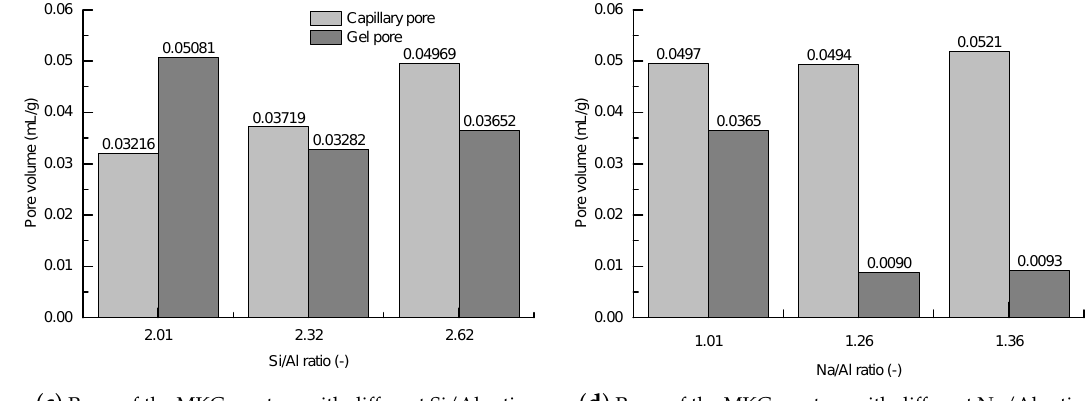
( d ) Pores of the MKG mortars with different Na/Al ratios Figure 5. Compositional dependence of the strength and pore structure of the MKG mortars: strength of the MKG mortars versus ( a ) the Si/Al ratio; ( b ) Na/Al ratio, pores of the MKG mortars versus the ( c ) Si/Al ratio and ( d ) Na/Al